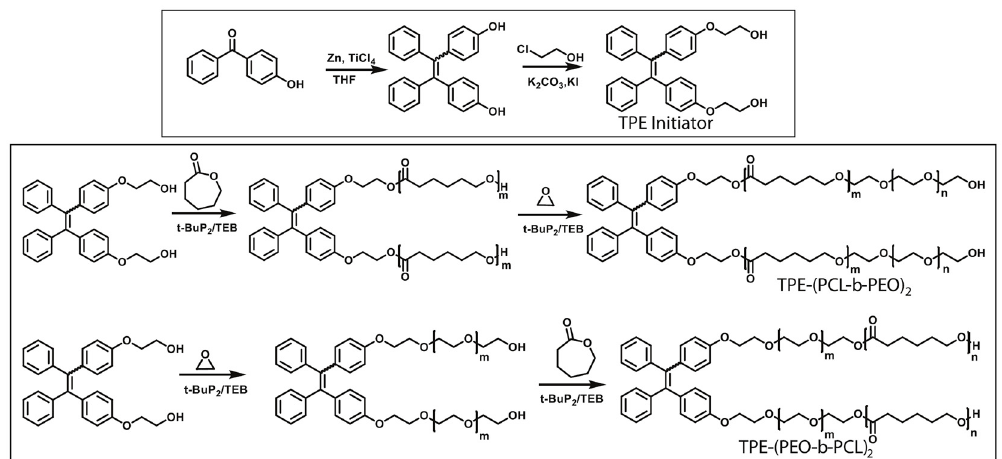
Figure 3. Synthesis of the TPE-2OH Initiator and TPE Containing Fluorescent Triblock Copolymers. Adapted from [27].